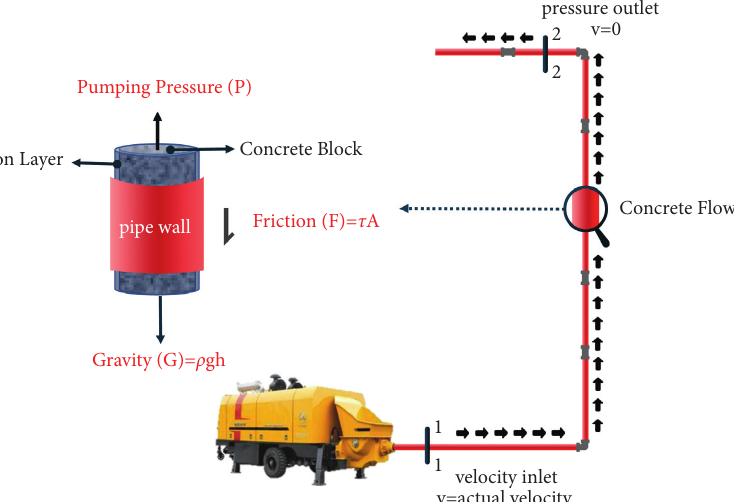
Figure 1: The diagrammatic sketch of concrete pumping and its mechanical analysis.